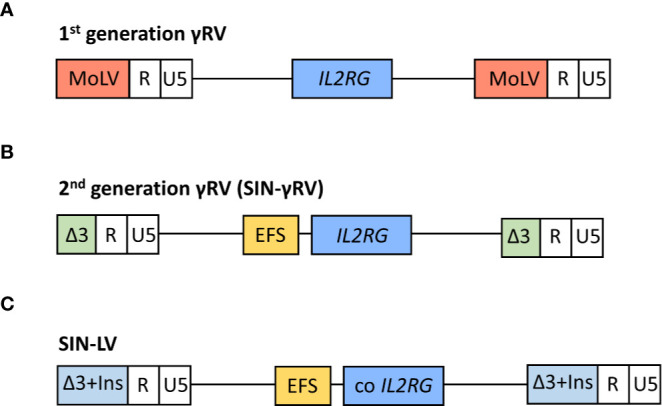
Schematic representation of viral vectors used in the different clinical trials for the treatment of SCID-X1 patients. In 1st generation γ retroviral vectors (γRVs), the gene expression is controlled by viral long terminal repeat (LTR) sequences (A). In 2nd generation self-inactivating (SIN) γRV and lentiviral vectors (LVs), the U3 region of LTR is deleted and the human interleukin-2 receptor γ gene (IL2RG) expression is driven by an internal mammalian promotor (B). Moreover, the LVs contain a codon optimized (co) IL2RG complementary DNA to further improve the transgene expression, and U3 region is replaced with a chromatin insulator element (Ins) (C). MoLV, Moloney murine leukemia virus; EFS, eukaryotic human elongation factor 1α (EF1α) short promoter.